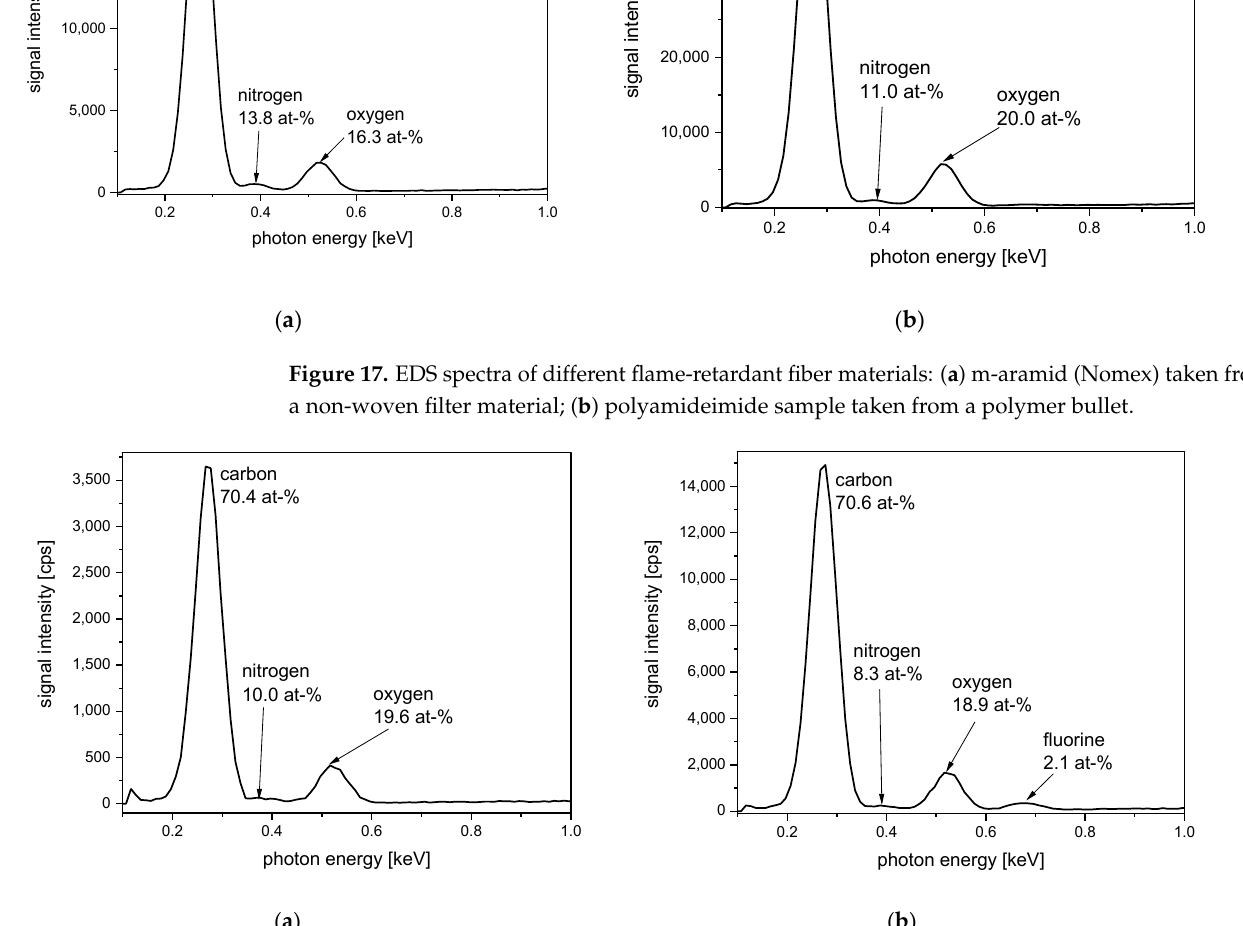
Figure 19. EDS spectrum of non-woven felt made from Kynol fibers. Panox fibers—also called Preox fibers or preoxidized fibers—are partly pyrolyzed PAN fibers with flame-retardant properties [102]. This is remarkable, because the original PAN fibers exhibit tremendous burning behavior [103]. The flame-retardant concept of Panox fibers is different from other flame-retardant fibers. It could be stated that, via the pyrolysis process, the burning processes are performed and finished in a controlled man- ner. Afterwards, the remaining fiber—as result of pyrolysis—is no longer able to burn.